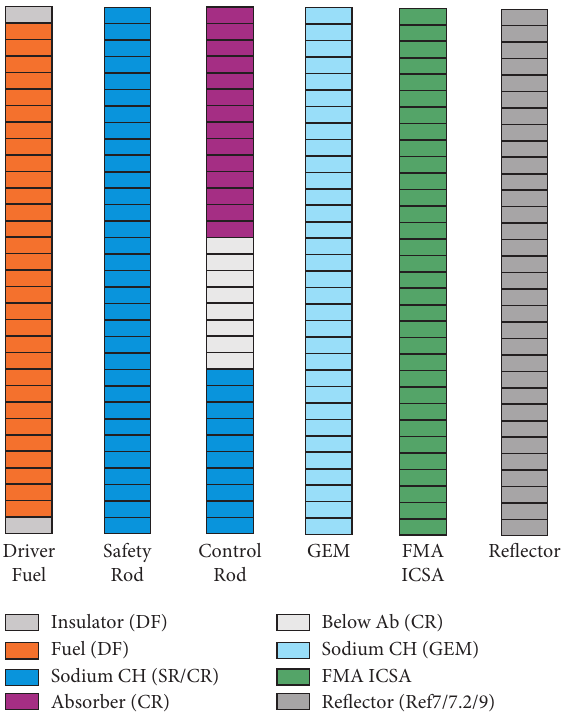
Figure 5: Schematic of calculation nodes division of FFTF in the axial